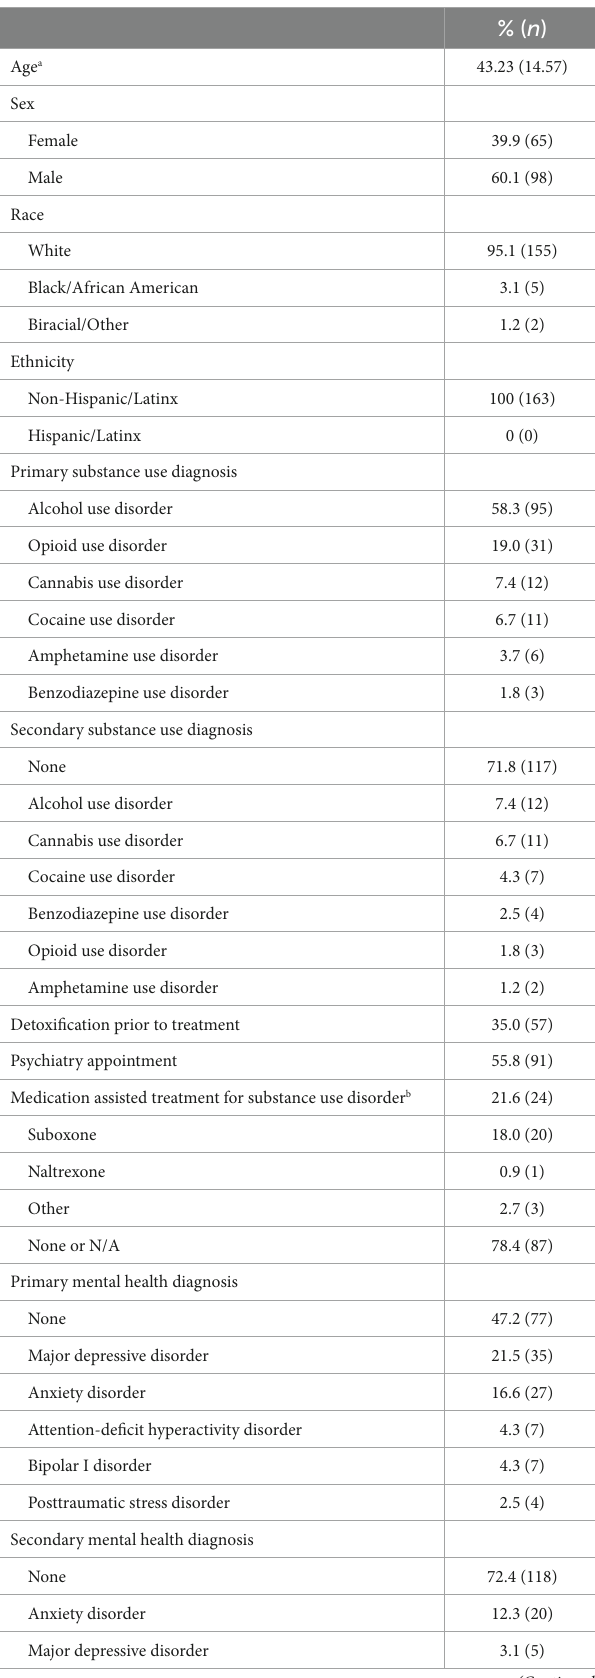
TABLE 2 Participant pre-intervention demographics, substance use, and mental health characteristics ( N =